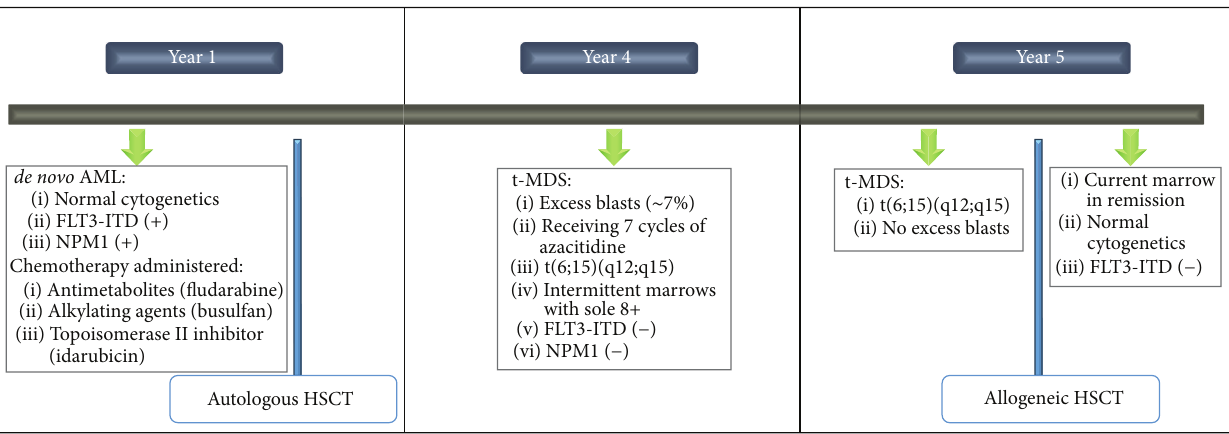
Figure 1: Summary of patient’s clinical history. AML, acute myeloid leukemia; FLT3-ITD, Fms-related tyrosine kinase 3-internal tandem duplication; t-MDS, therapy-related myelodysplastic syndrome; NPM1, nucleolar phosphoprotein B23; HSCT, hematopoietic stem cell transplantation; t,